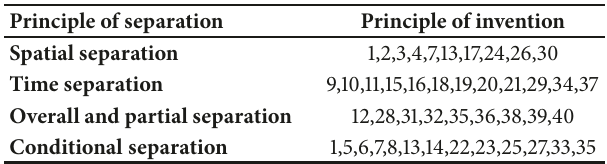
Table 2: Correspondence between separation principle and inven- tion